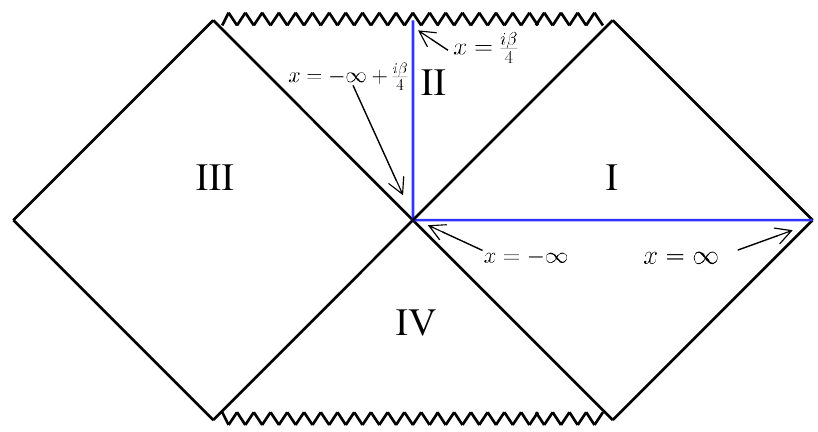
Figure 2 . Penrose diagram of a Schwarzschild BH. To reach region II, we shift the tortoise coordi- nates: x ! x + i(cid:12)= 4 ; t ! t + i(cid:12)= 4. The blue lines are the t = 0 slices in regions I & II. The horizon is mapped to x = (cid:0)1 in both